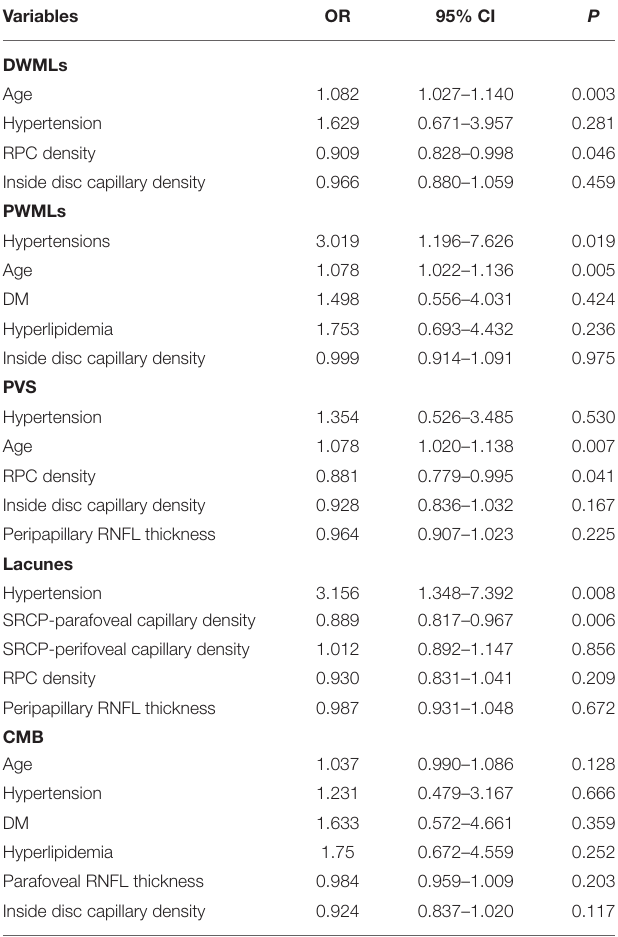
TABLE 3 | Multivariate analysis of the related factors for each type of CSVD.